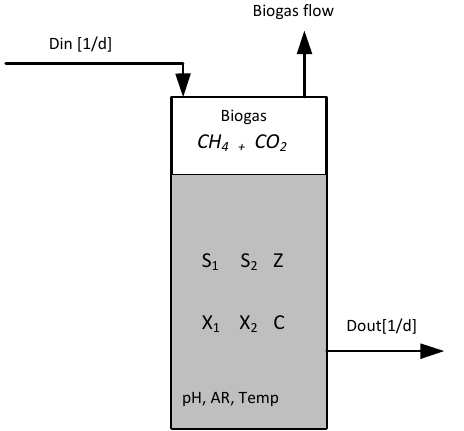
Figure 2: An anaerobic digestion reactor with variables according to the AM2